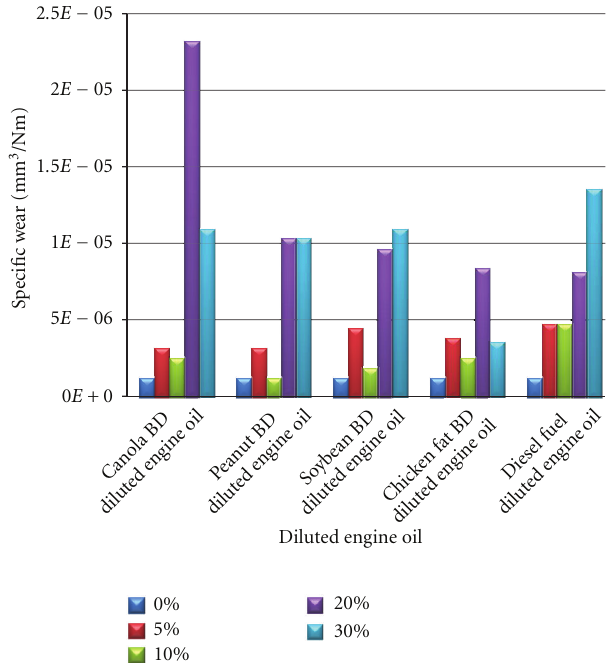
Figure 10: Specific wear for mixtures of all four types of biodiesel (BD) and fossil diesel diluting engine oil.